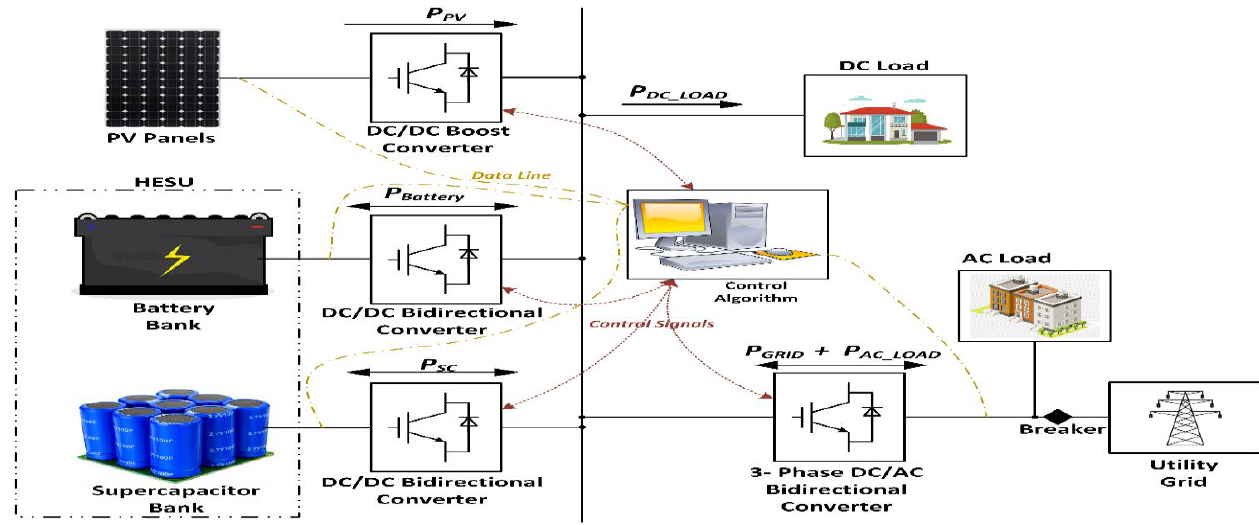
Figure 22. Block diagram for the experimental set-up .